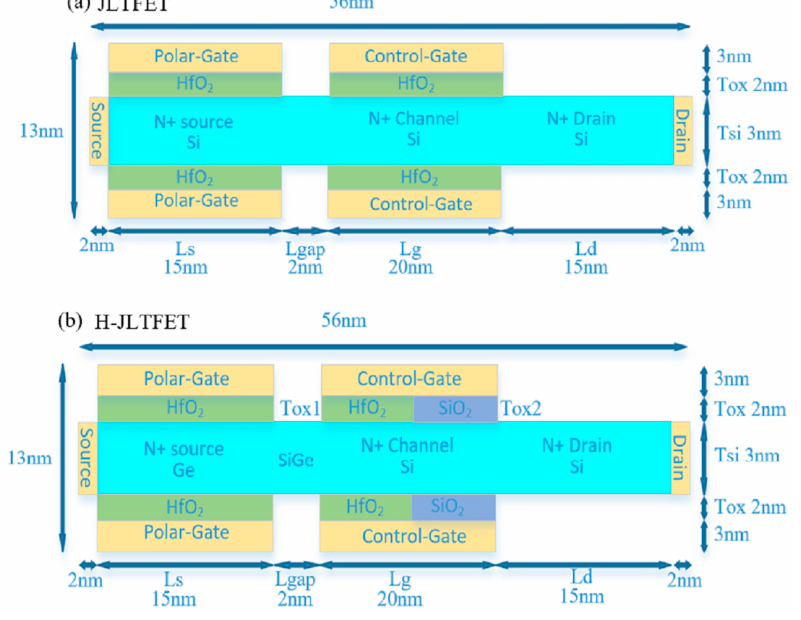
Figure 1. Device structure schematic of ( a ) JLTFET; and ( b ) H-JLTFET.